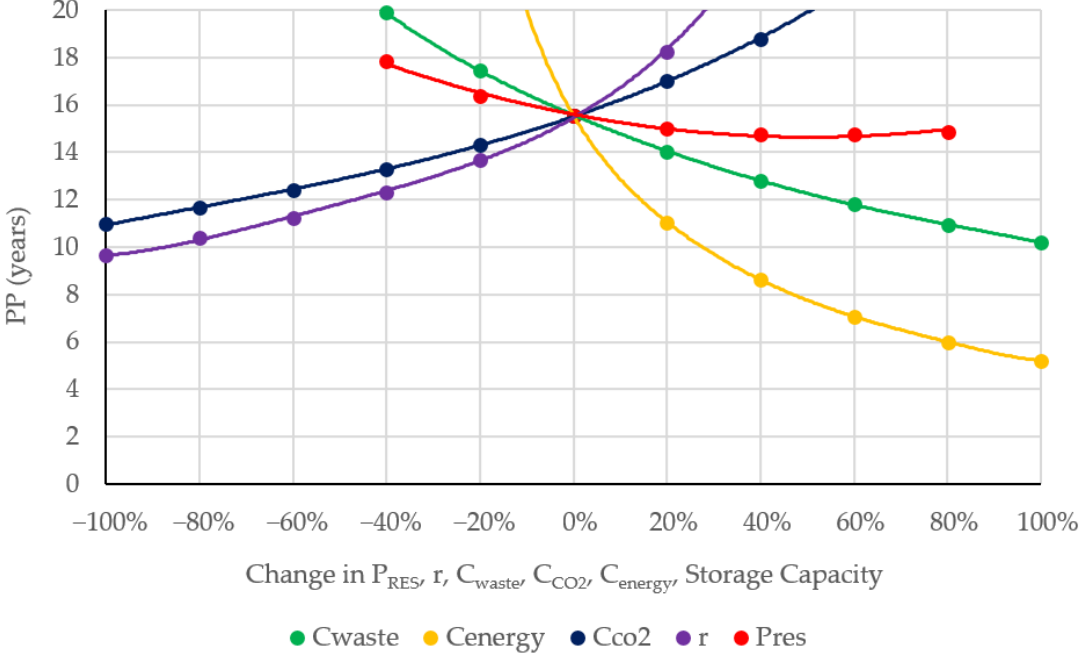
Figure 17. Impact of changes in the system parameters on the payback period.